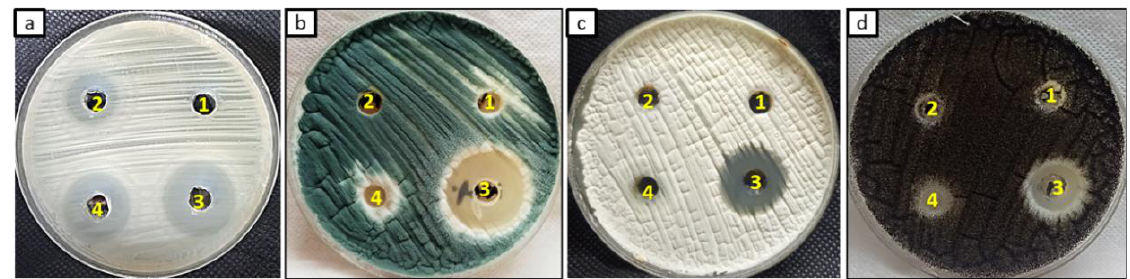
Figure 6. Antifungal activity of Chi (1), Ag+ (2), Chi/Ag-NPs (3), and Nystatin (4) toward C. albicans Table 2. Inhibition zones and MIC of Chi/Ag-NPs compared to start materials.